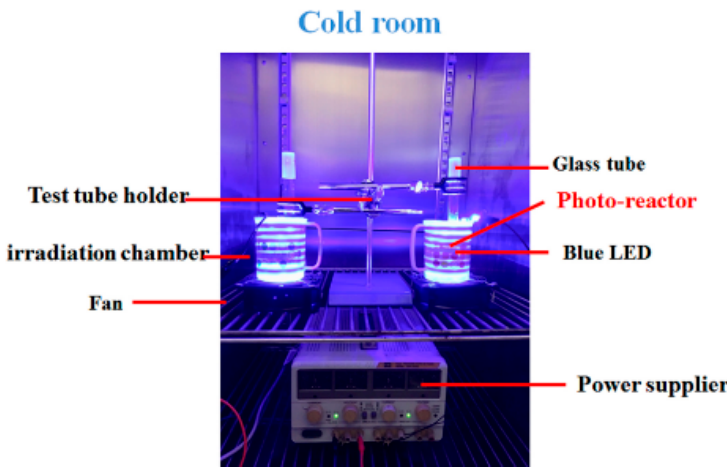
Figure 8. Set-up of the photoreaction system.